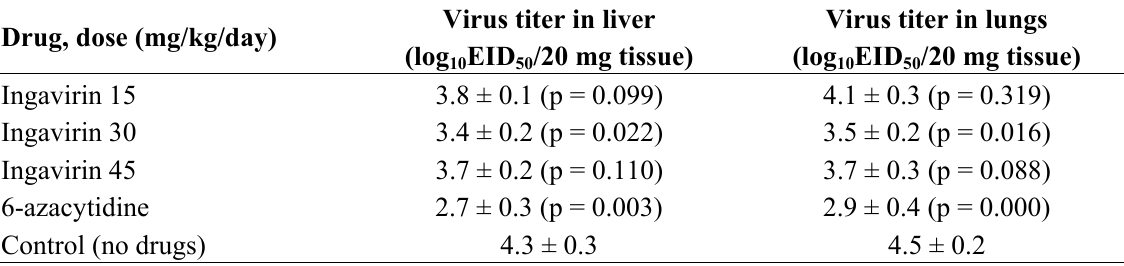
Table 3. Infectious activity of AdV in liver and lungs of Syrian hamsters after application of